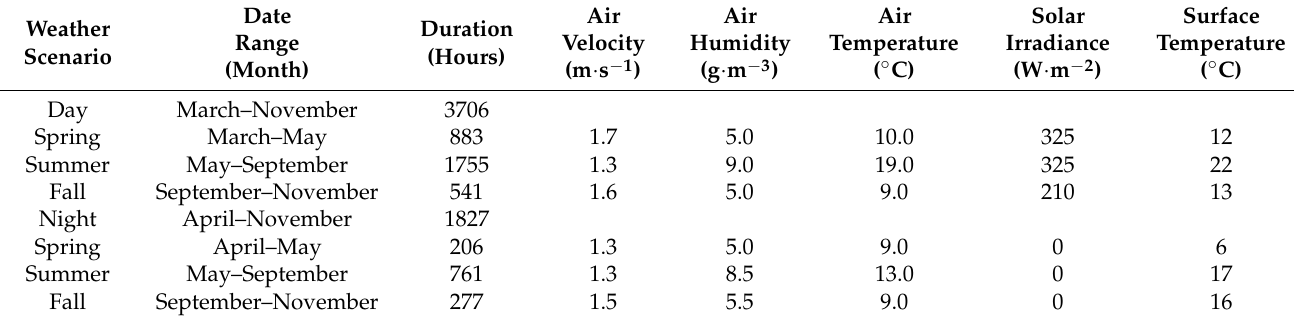
Table 1. Selected atmospheric parameters in the study area, modified after Suchan and Azam